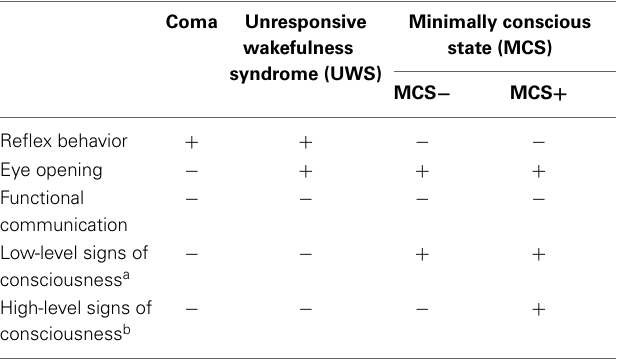
Table 1 | Clinical diagnostic criteria of disorders of consciousness (DOC) (Bodard et al.,